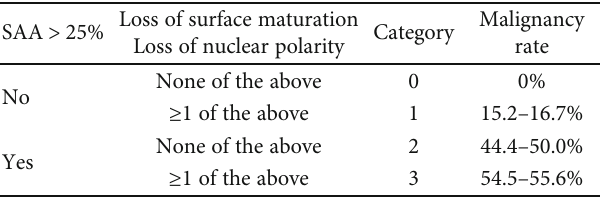
Table 6: Criteria for risk strati fi cation of inde fi nite for dysplasia and malignancy rates. SAA > 25 % Loss of surface maturation Loss of nuclear